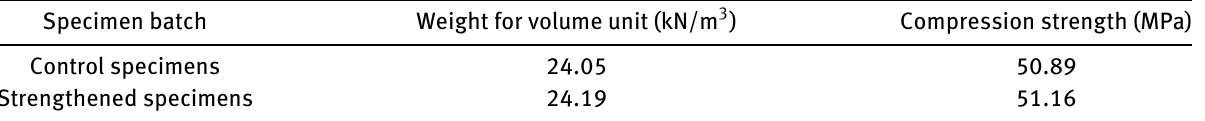
Figure 1: Concrete batch Figure 2: Concrete samples for compressive test Table 2: Concrete